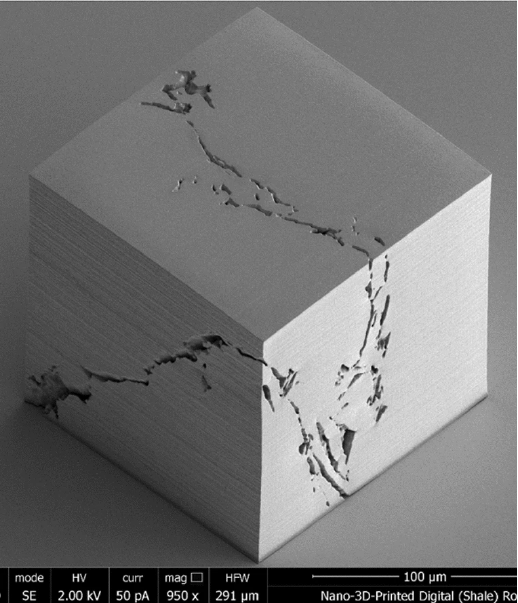
Figure 22 . MPP-printed 150 μ m 3 cube of replica shale rock with nanoscale features, where the im- Figure 22. MPP-printed 150 µ m 3 cube of replica shale rock with nanoscale features, where the image is taken with an electron microscope age is taken with an electron microscope [15].